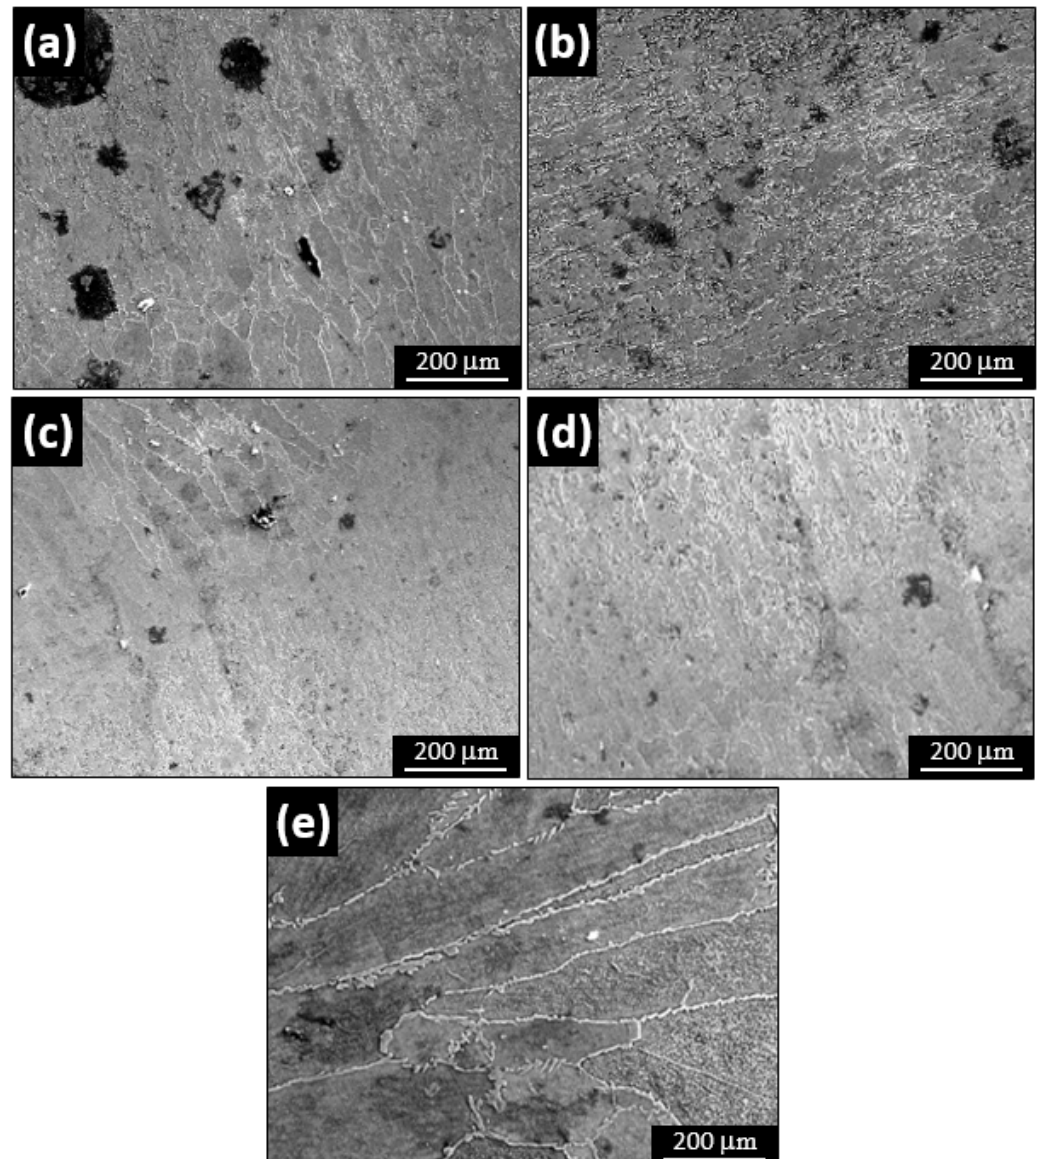
Figure 5. SEM images of 2205 duplex stainless-steel in the different solution with 3.5% NaCl at different pH ( a ) pH 2, ( b ) pH 5, ( c ) pH 7 ( d ) pH 10, and ( e ) pH 13. ( b ) pH 5, ( c ) pH 7 ( d ) pH 10, and ( e ) pH